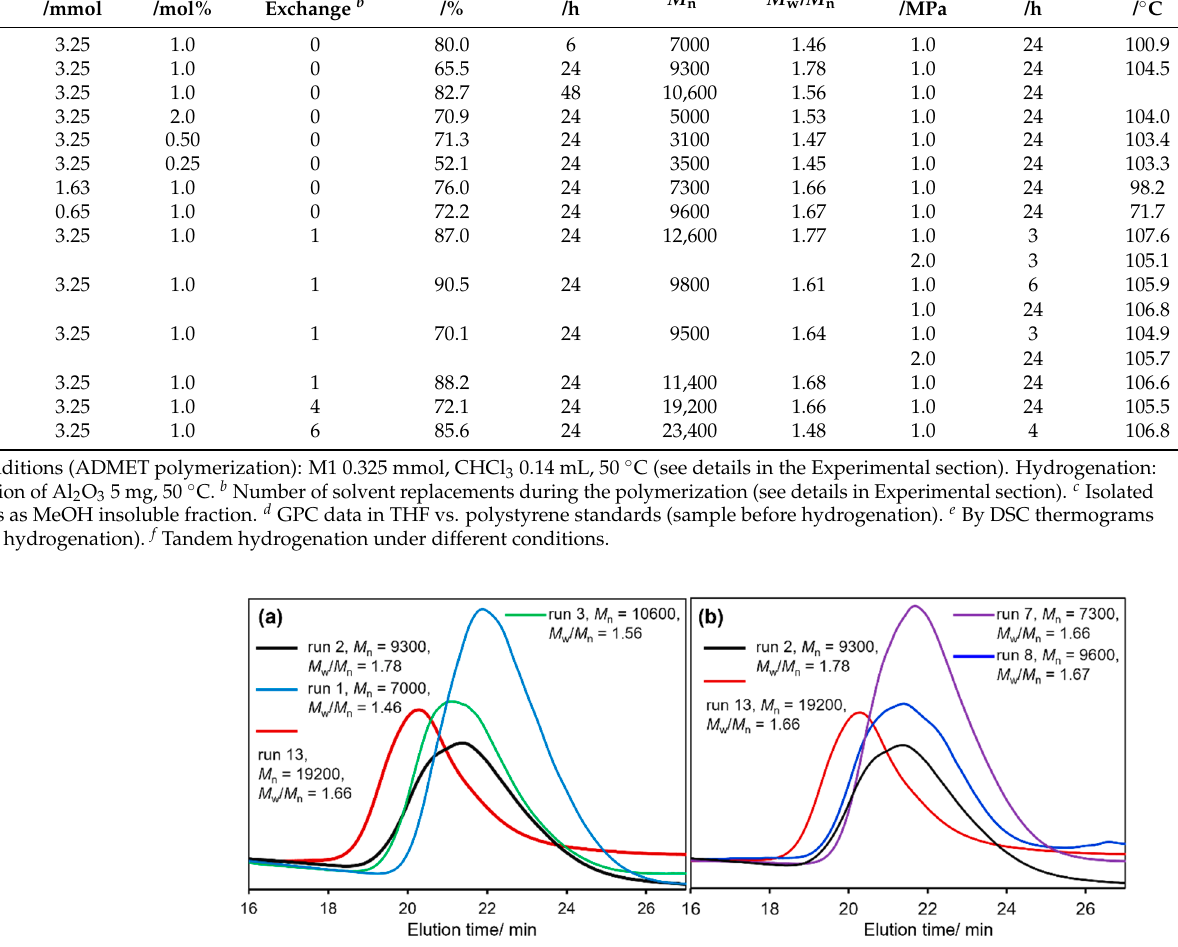
Table 1. ADMET copolymerization of M1 with 1,9-decadiene (DCD) a .